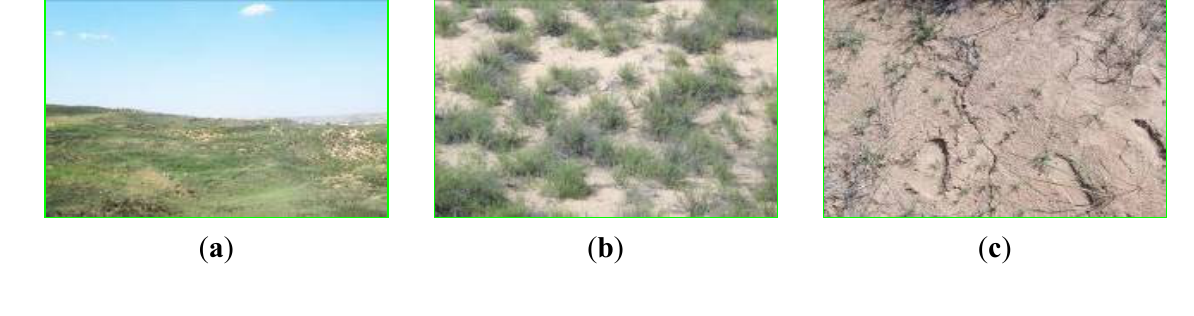
Figure 3. Surface morphology of the BCM: ( a ) overall perspective; ( b ) sandy vegetation; and ( c ) barchan